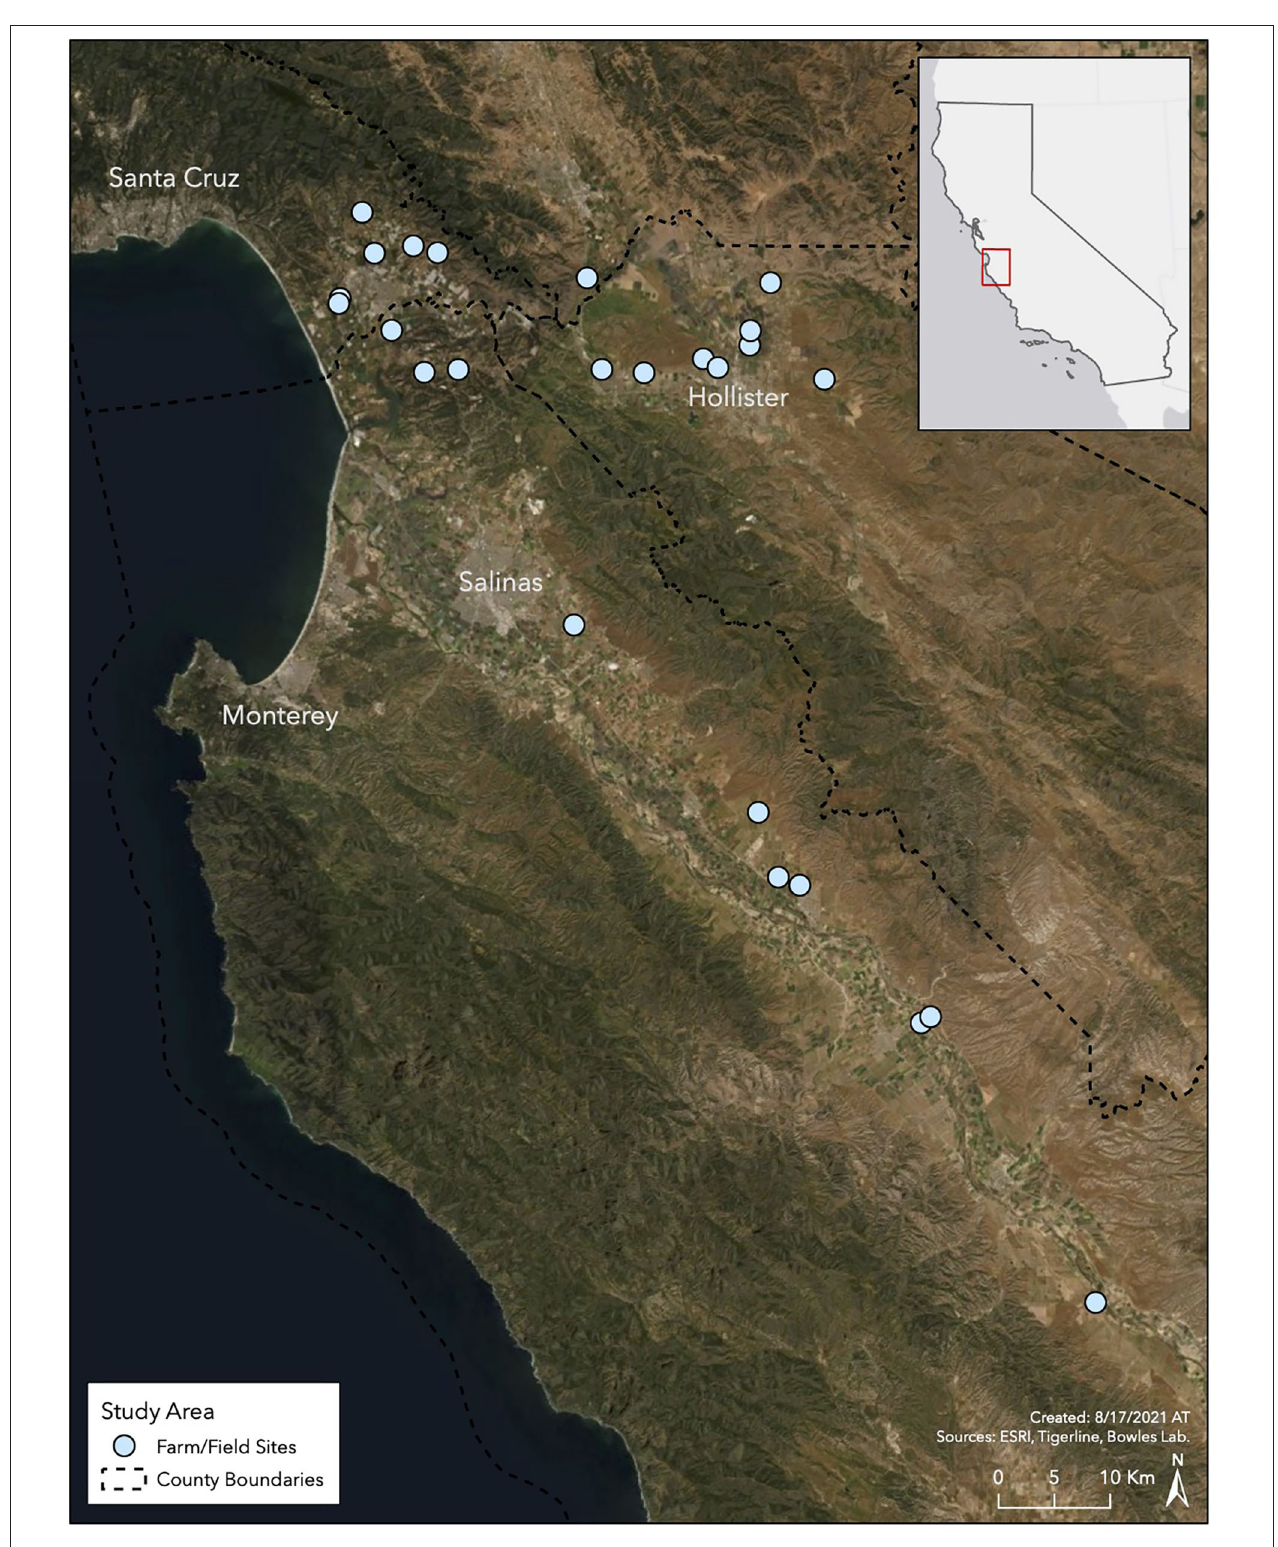
FIGURE 1 | Map of the Central Coast Region. A map of the study region showing the distribution of farm and field sites. Some farms had multiple field locations where ecological surveys were conducted, hence there are more points than number of interviews.